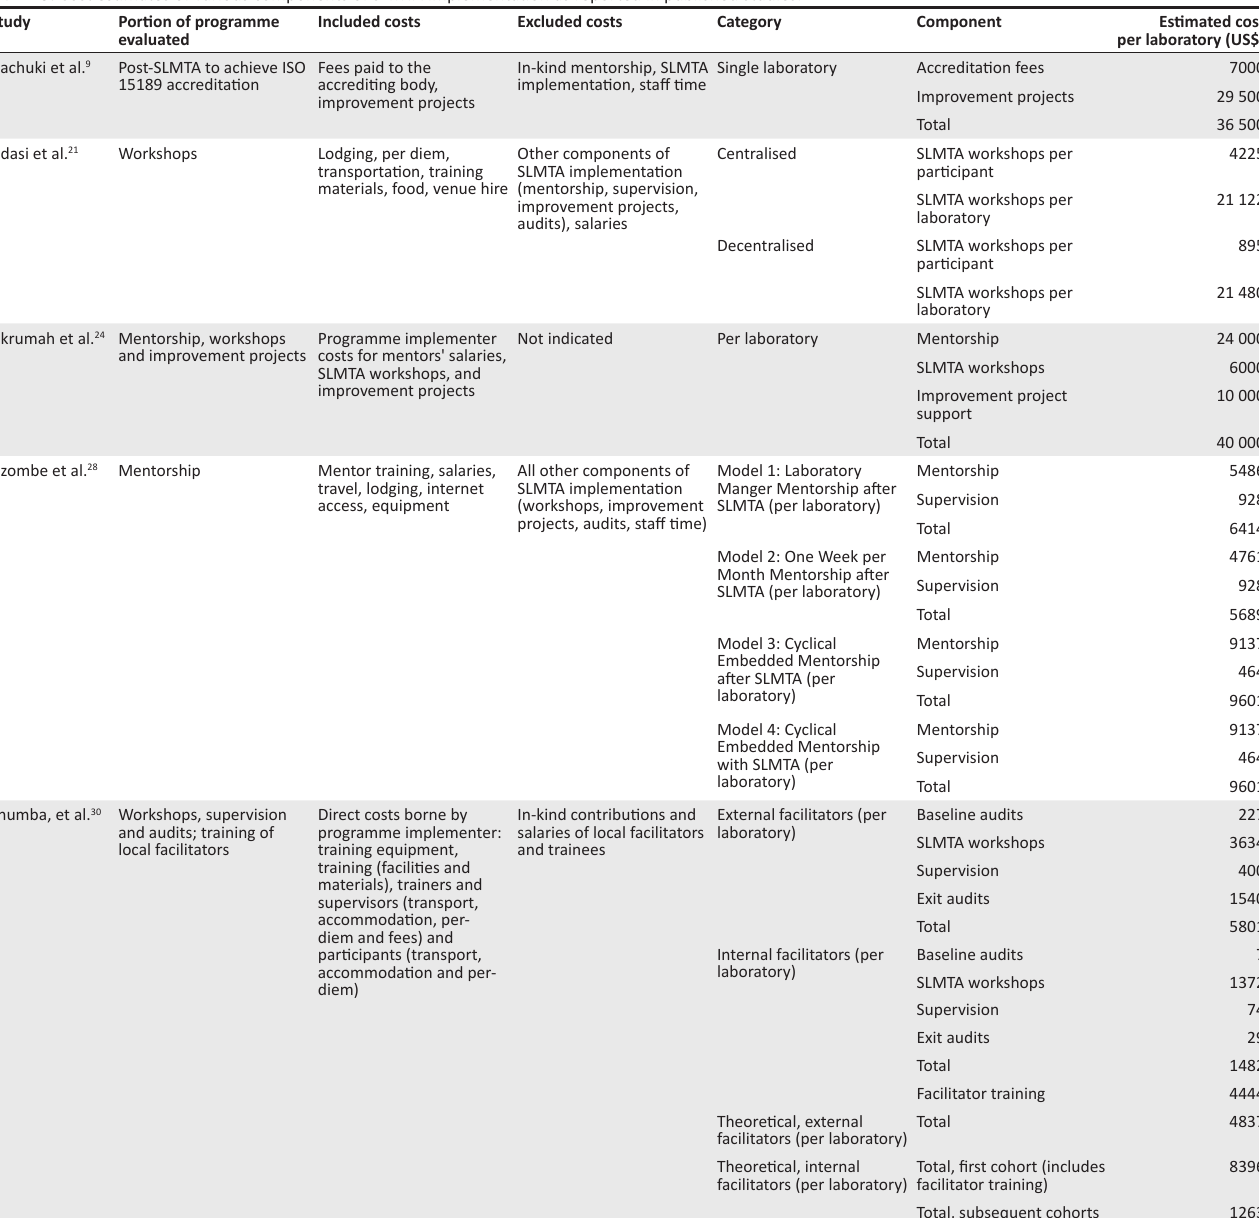
TABLE 3: Cost estimates of various components of SLMTA implementation as reported in published studies. Study Portion of programme